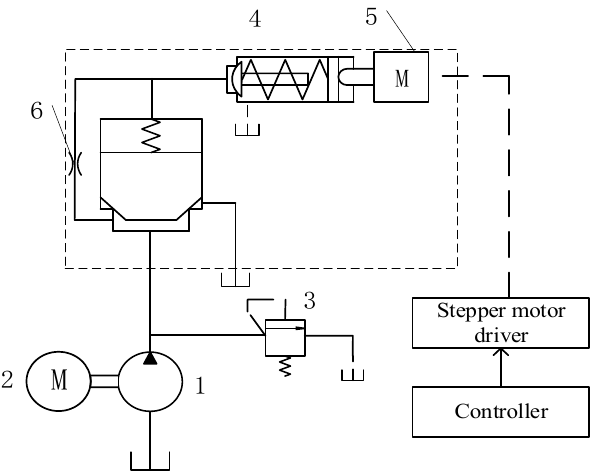
Figure 1. Schematic of a digital relief valve driven by a linear stepper motor. 1—Pump being tested; 2—motor; 3—safety valve; 4—digital relief valve; 5—linear stepper motor; 6—damping